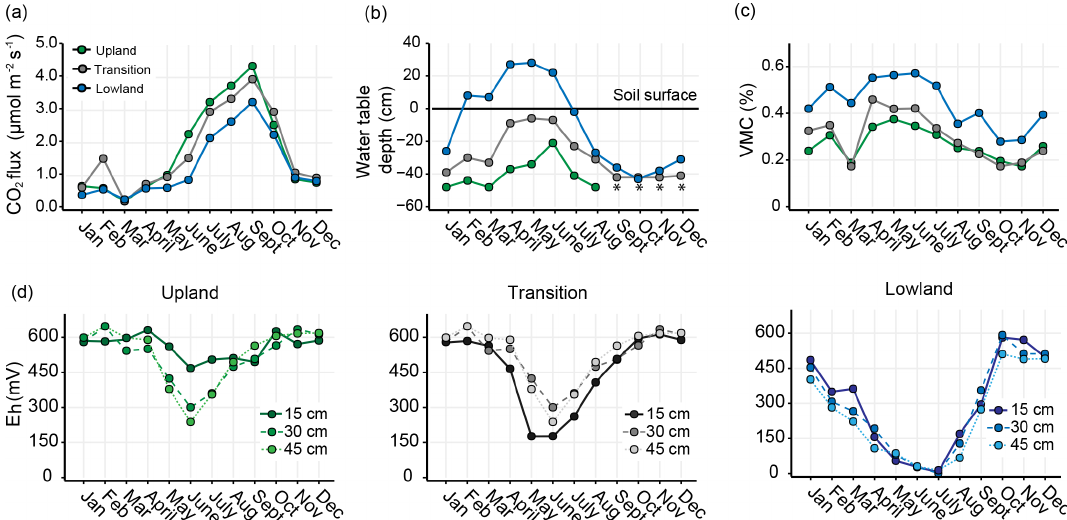
Figure 2. CO 2 efflux, water table, moisture and redox dynamics along upland–lowland transects. Mean monthly (a) soil CO 2 efflux, (b) water table depths, (c) volumetric moisture contents, and (d) depth-resolved redox potentials for the three landscape positions; upland, transition and lowland. Redox potentials are standardized from a calomel to a standard hydrogen electrode. Data are the means of measurements along upland–lowland transects in six replicate wetlands. Missing data points for the upland position in panel (b) are due to the water table dropping below the measuring gauge installed at a depth of 50cm and is denoted with asterisks